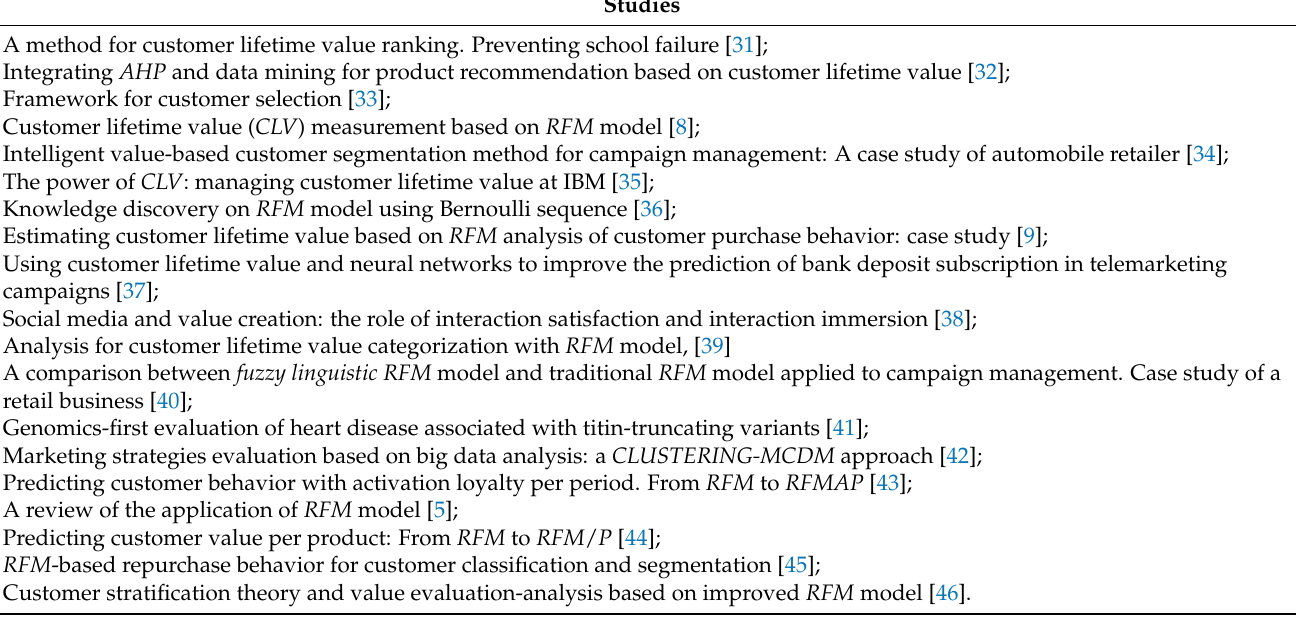
Table 2. CLV-Related Studies.